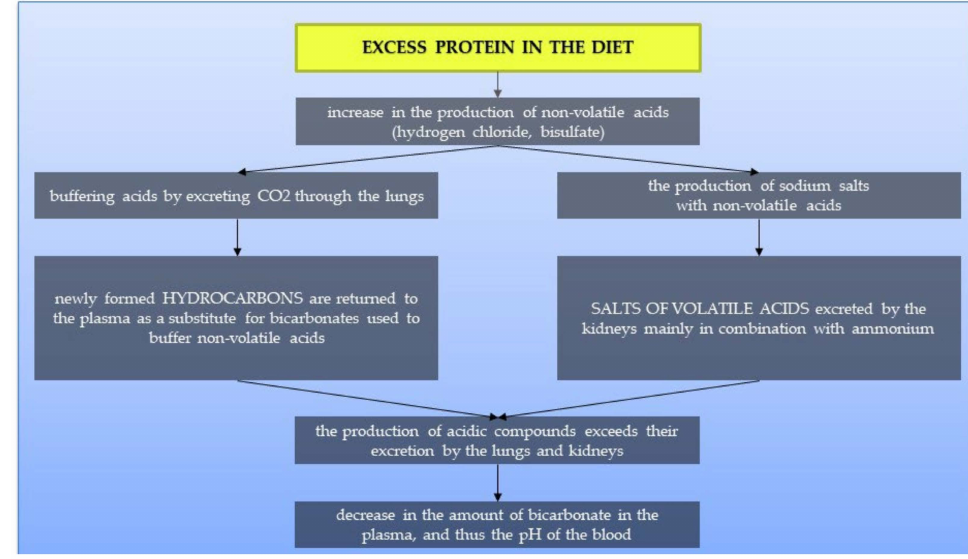
Figure 5. Effect of a high-protein diet on blood